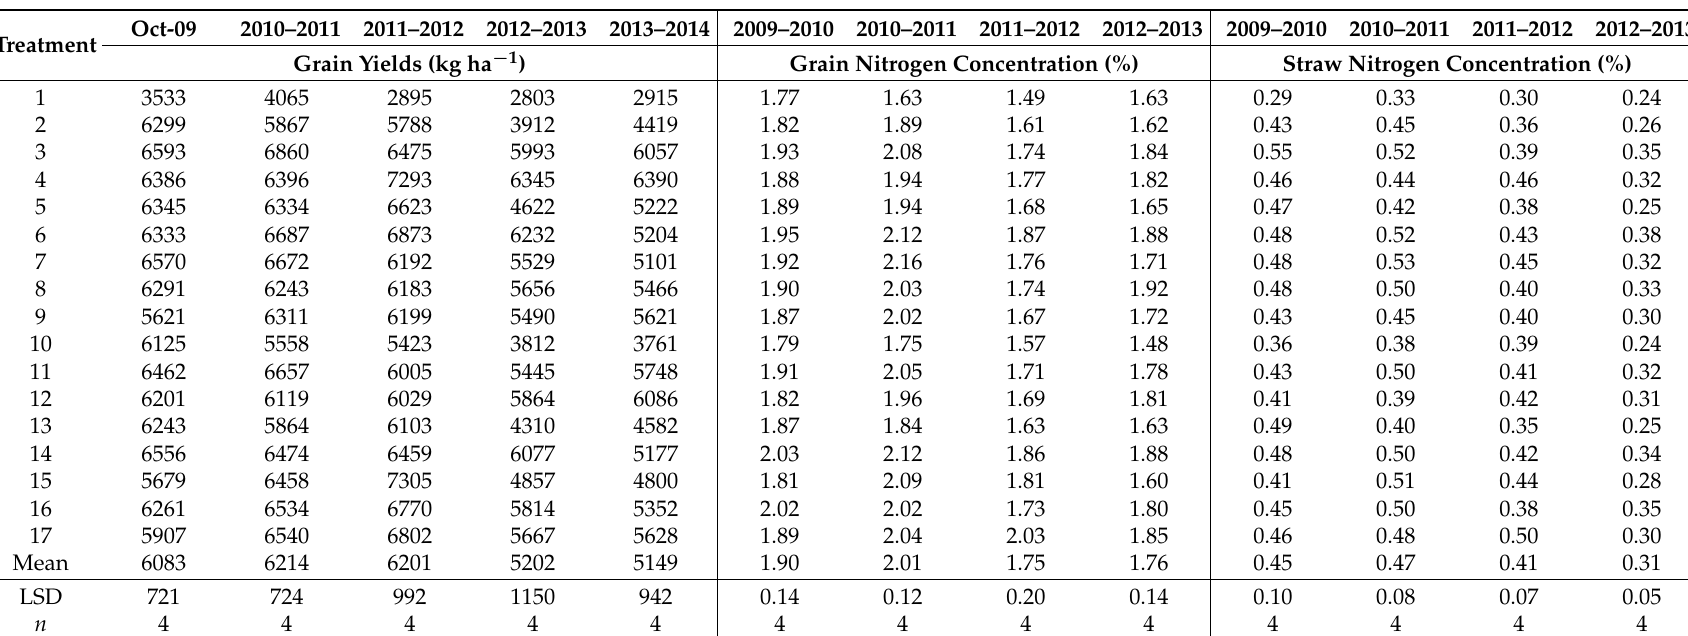
Table 4. Means of wheat yields in five growing cycles (2009–2010 to 2013–2014), and nitrogen concentration in grain and in straw in four cycles (2009–2010 to 2012–2013), as influenced by selected treatments composed of urea sources, timing, and method of fertilizer application at the International Maize and Wheat Improvement Center (CIMMYT), in the Yaqui valley, near Ciudad Obregon, Sonora,